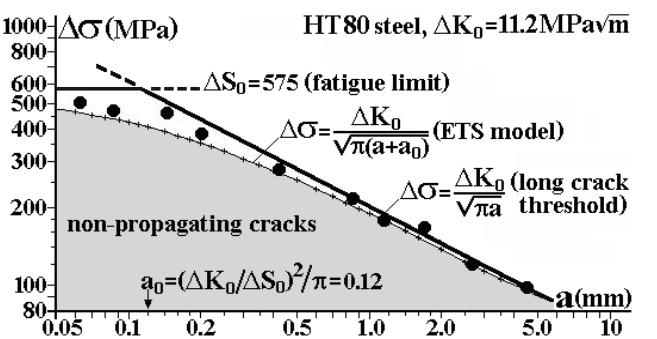
Figure 2: Kitagawa-Takahashi plot describing the fatigue propagation of short and long cracks under pulsating loads ( R = 0) in HT80 steel with  K = 11.2 MPa  m and  S = 575 0 0